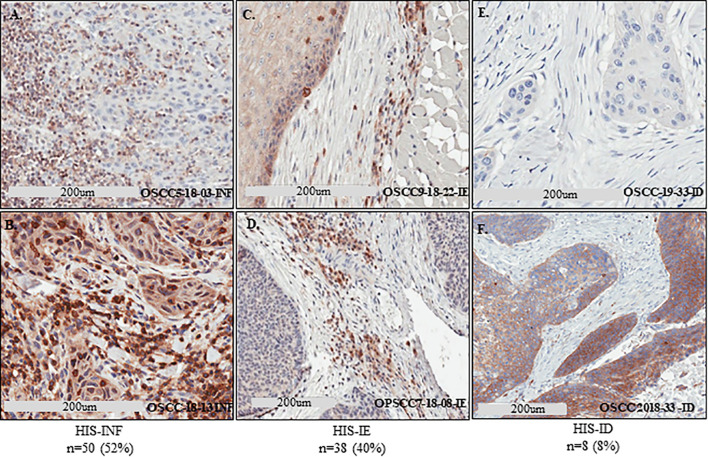
Defining the HIS subtypes in HNSCC using Sema4D. IHC stain of Sema4D in HNSCC tissue. (A, B). HIS-INF OSCC tumors demonstrating IC infiltrate into the core of the tumor islands. (C, D). HIS-IE in OSCC (C) and base of tongue SCC (D), shows IC excluded from tumor island by a rim of PTSF (C) or FMX rim (D). (E, F). HIS-ID in OSCC showing cold non-inflamed fibrotic dense stroma deserted of IC. IHC, immunohistochemistry; HIS, histological inflammatory stroma subtype; INF, inflamed; IE, immune excluded; ID, immune desert; FMX, fibromyxoid; PTSF, peri-tumoral stromal fibrosis.